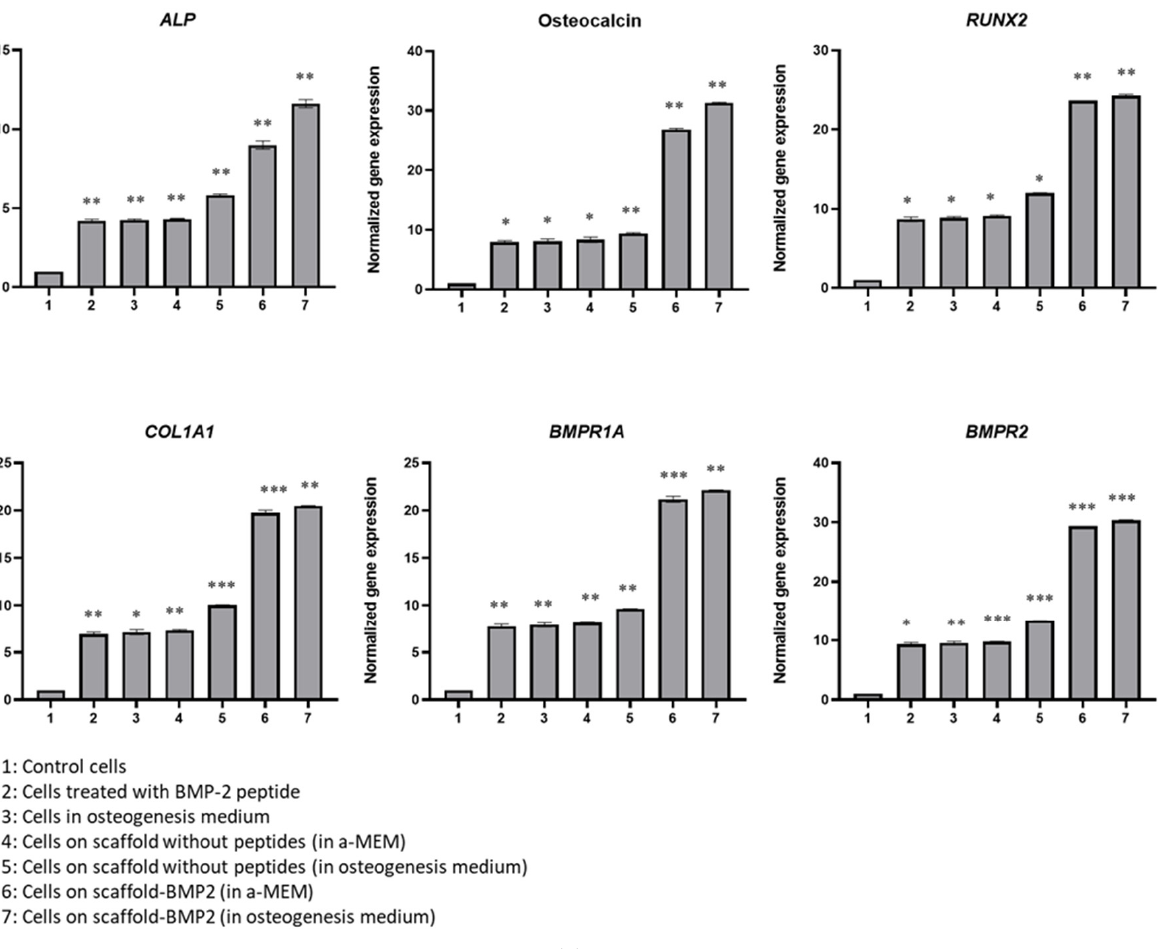
( b ) Figure 9. ( a ) Relative quantification of the mRNA levels of osteogenic markers ALP , Osteocalcin, RUNX2 , COL1A1 , BMPR1A , and BMPR2 after 21 days of differentiation of hDPSCs on the scaffolds